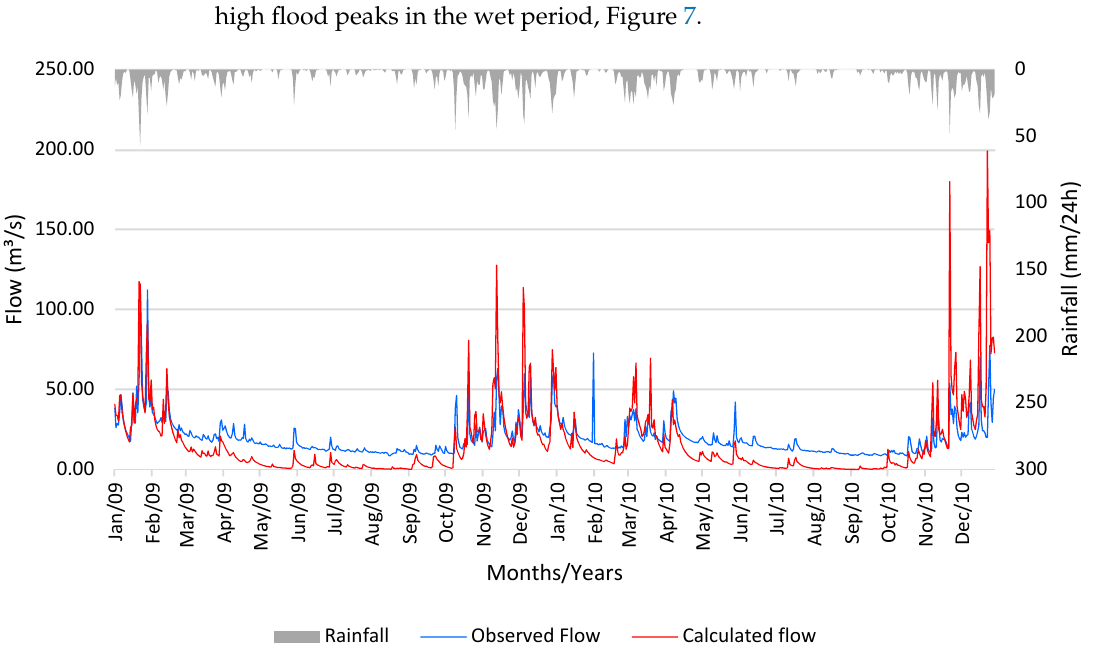
Figure 7. Uncalibrated comparison between estimated flow and simulated flow in SWAT defined by the left axis, while the right axis represents daily precipitation.